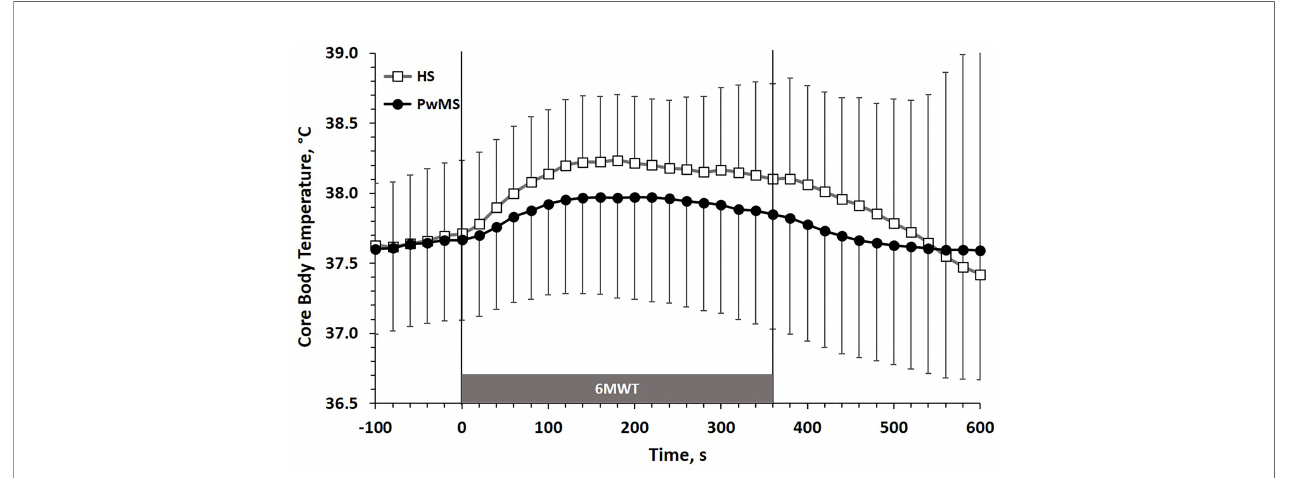
FIGURE 1 | CBT (m±SD) time course before, during and after the 6MWT. HS, Healthy Subjects; PwMS, Persons with Multiple Sclerosis. Black line and close circles: PwMS; grey line and open squares: